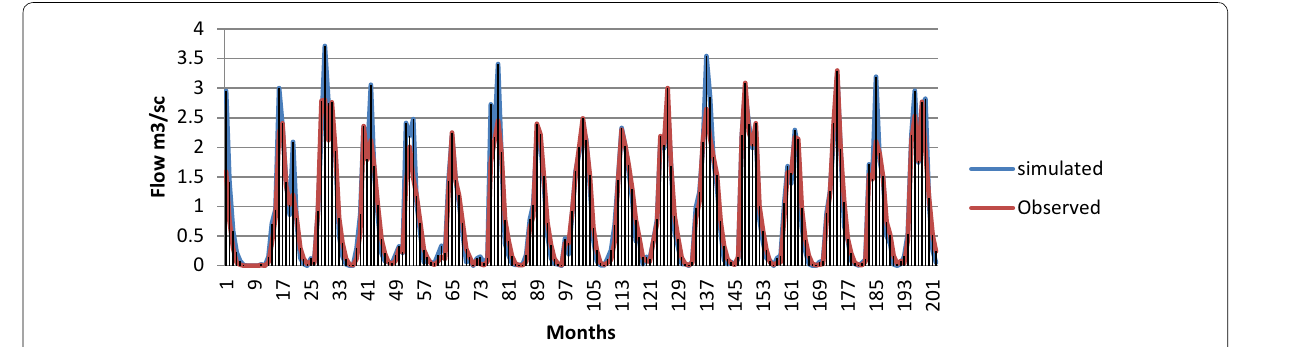
Fig. 6 Observed and simulated flow rate during calibration